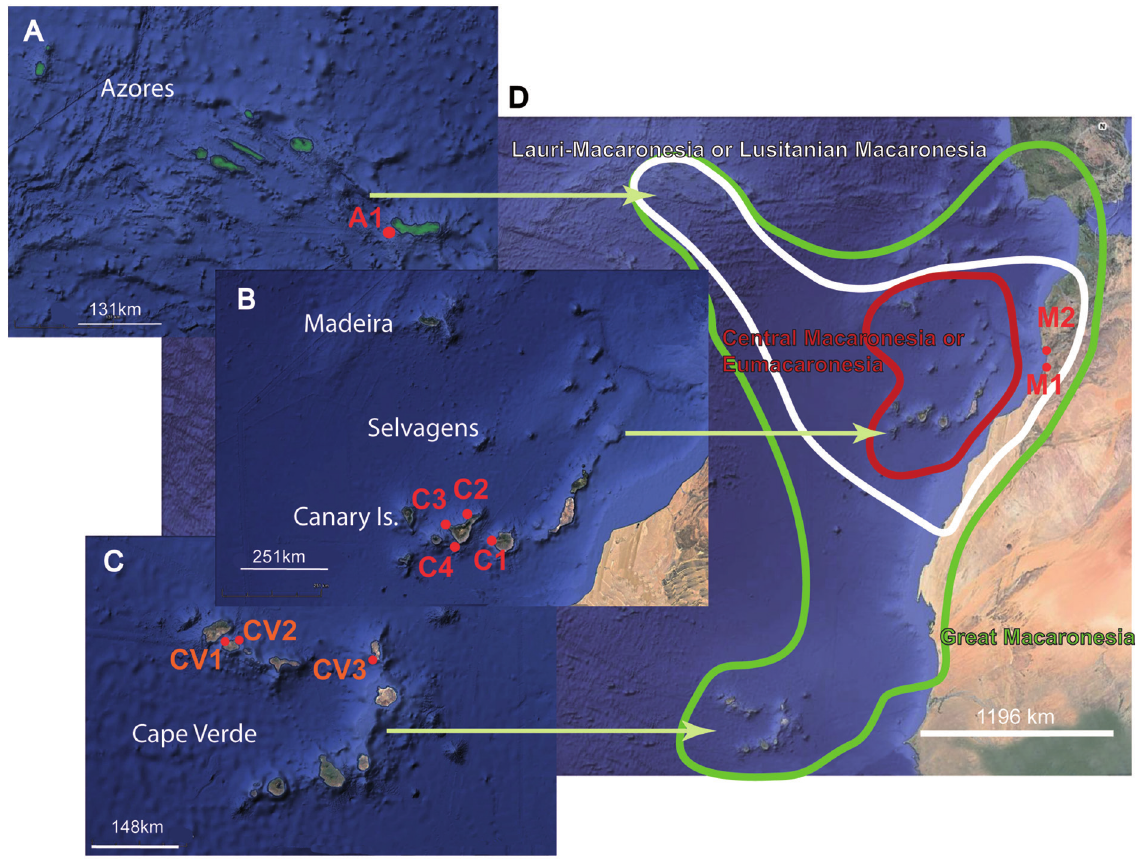
Fig. 1. Location of sampling points, distribution of the Macaronesian archipelagos and limitation of regions: Lauri-Macaronesia or Lusitanian Macaronesia (white); Central Macaronesia or Eumacaronesia (bordeaux) and Great Macaronesia (green). Abbreviations: A1 = San Miguel Island, Azores; C1 = Pasito Blanco, Gran Canaria, Canary Islands; C2 = Tenerife, Canary Islands; C3 = Garachico, Tenerife, Canary Islands; C4 = Amarilla Golf, Tenerife, Canary Islands; CV1 = Astillero Mindelo, São Vicente Island, Cape Verde; CV2 = Bahía das Gatas, São Vicente Island, Cape Verde; CV3 = Calheta Funda, Sal Island, Cape Verde; M1 = Ifni, South Morocco; M2 = Agadir, South